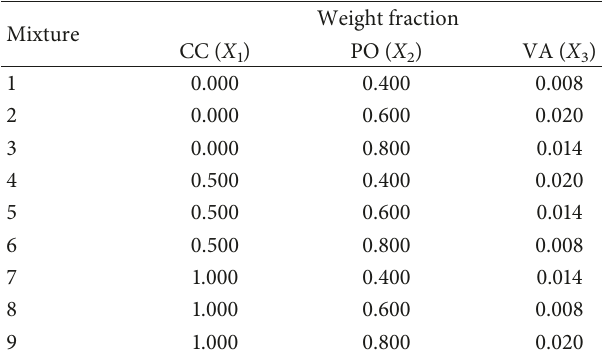
Table 3: Mixture compositions (weight fractions of chosen factors only) in the 3 3 − 1 fractional factorial design.